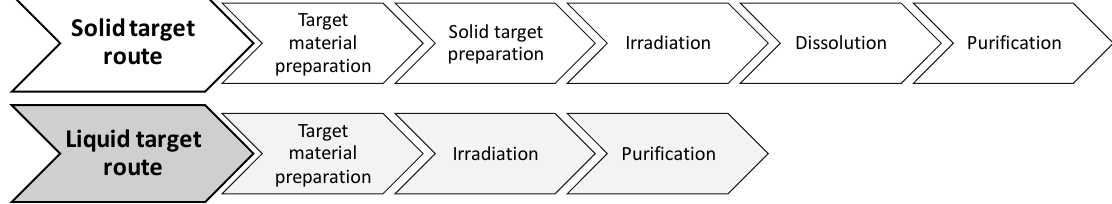
Figure 1. Solid and liquid routes to produce radiometals in a medical low energy cyclotron.